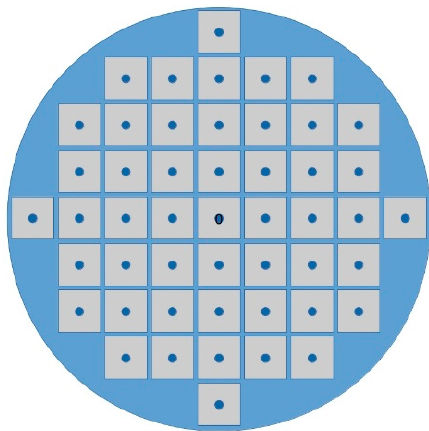
Figure 3. Schematic of the 5 × 5 mm 2 sensing elements realized on the 2-inch silicon wafer. After slicing, about 50 different sensing elements were produced.